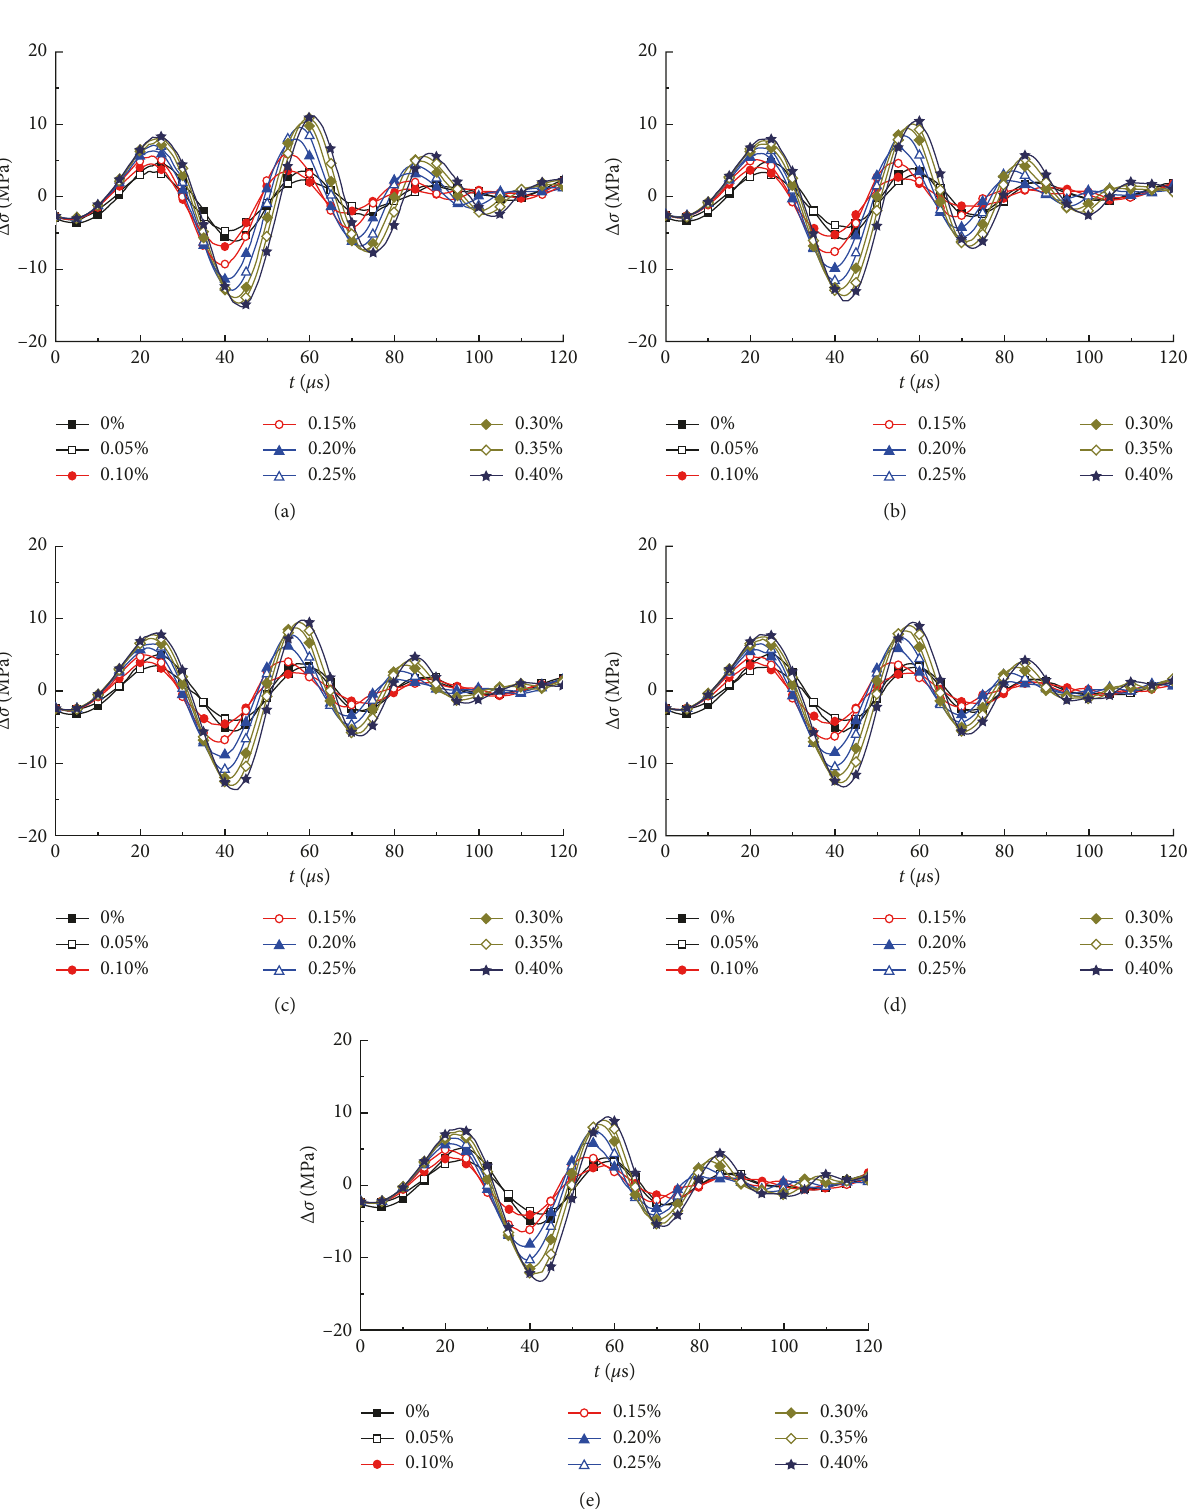
t σ for various end-surface nonparallelisms and Young’s moduli: (a) E ( ) (cid:30) Δ